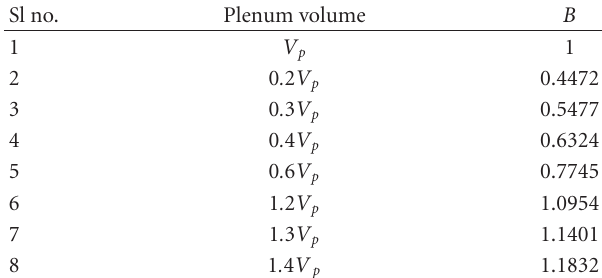
Table 1: Di ff erent sizes of plenum V p with respect to B = 1 case. Sl